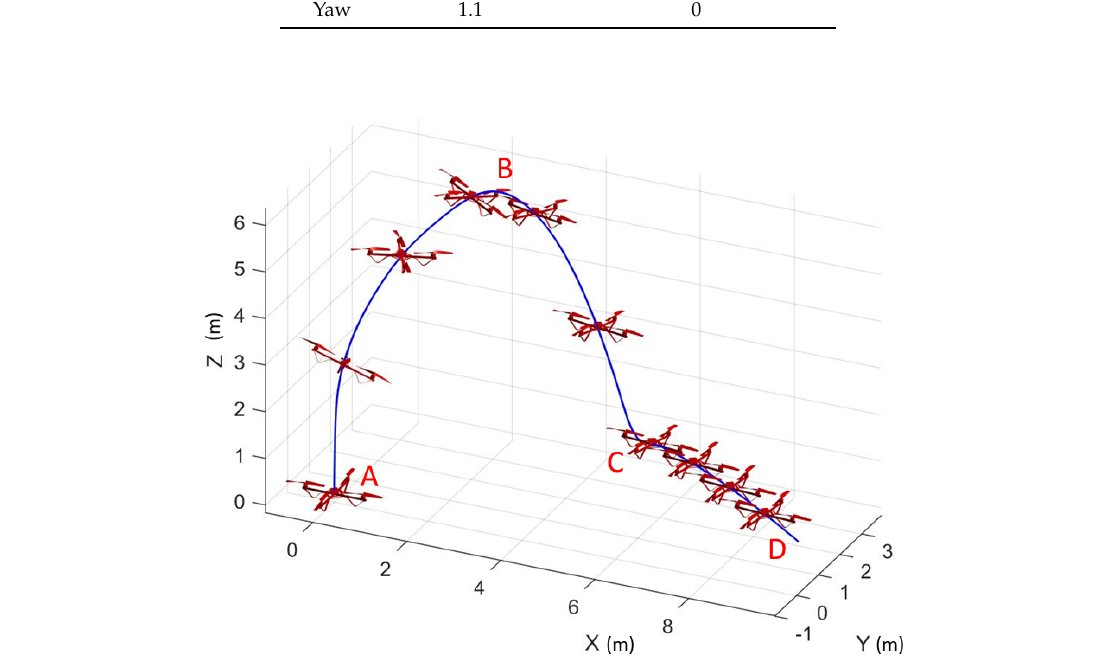
Figure 7. Path and waypoints of the quadrotor in simulation